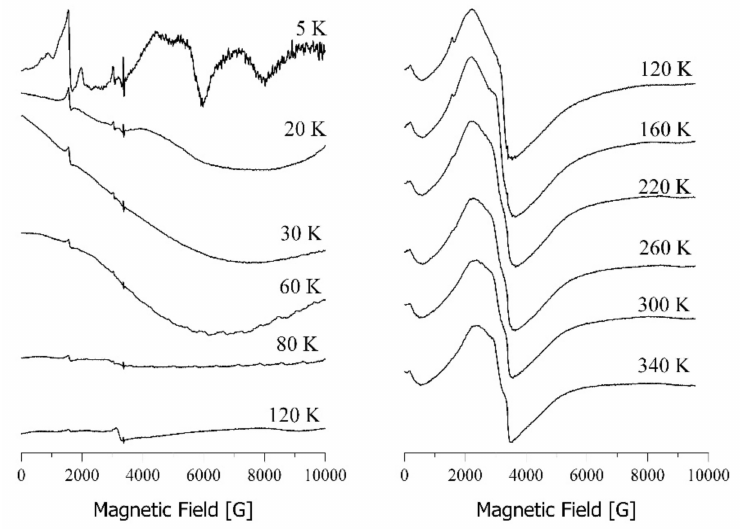
Figure 4. The temperature dependence of the EPR X-band spectra of 1 from 5 K to 340 K.